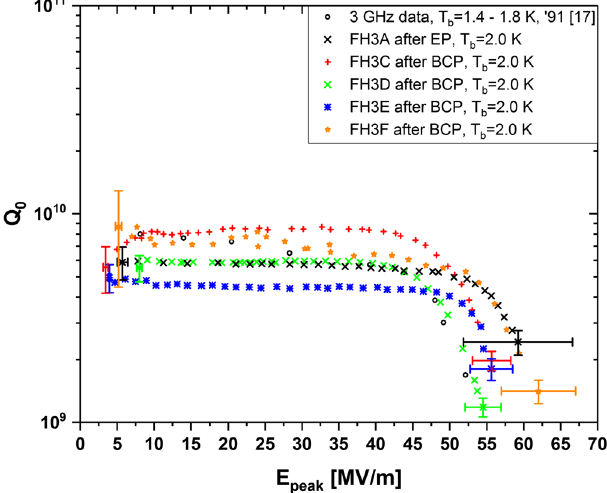
FIG. 8. FH3C, FH3D, and FH3E at T b ¼ 2 . 0 K are plotted here along with the earlier data reproduced from [15]. E 1 . 83 was used for the 3 GHz cavities. Note that the temperature of the helium bath increased from about 1.4 K to about 1.8 K with rf dissipated power during the earlier measurements in 1991.